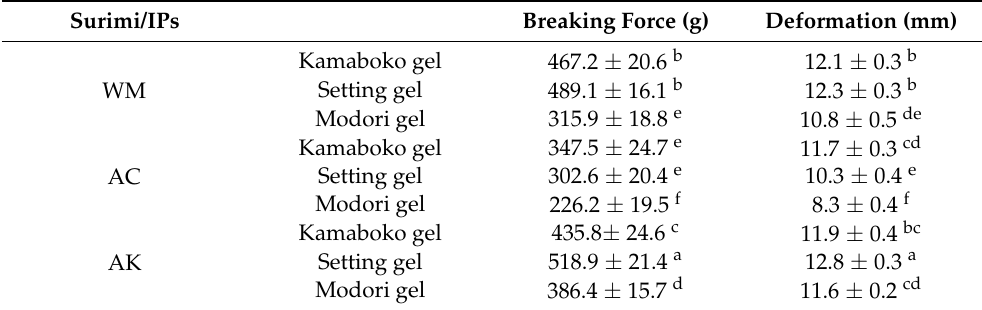
Table 3. Breaking force and breaking deformation of gel prepared under different processes and